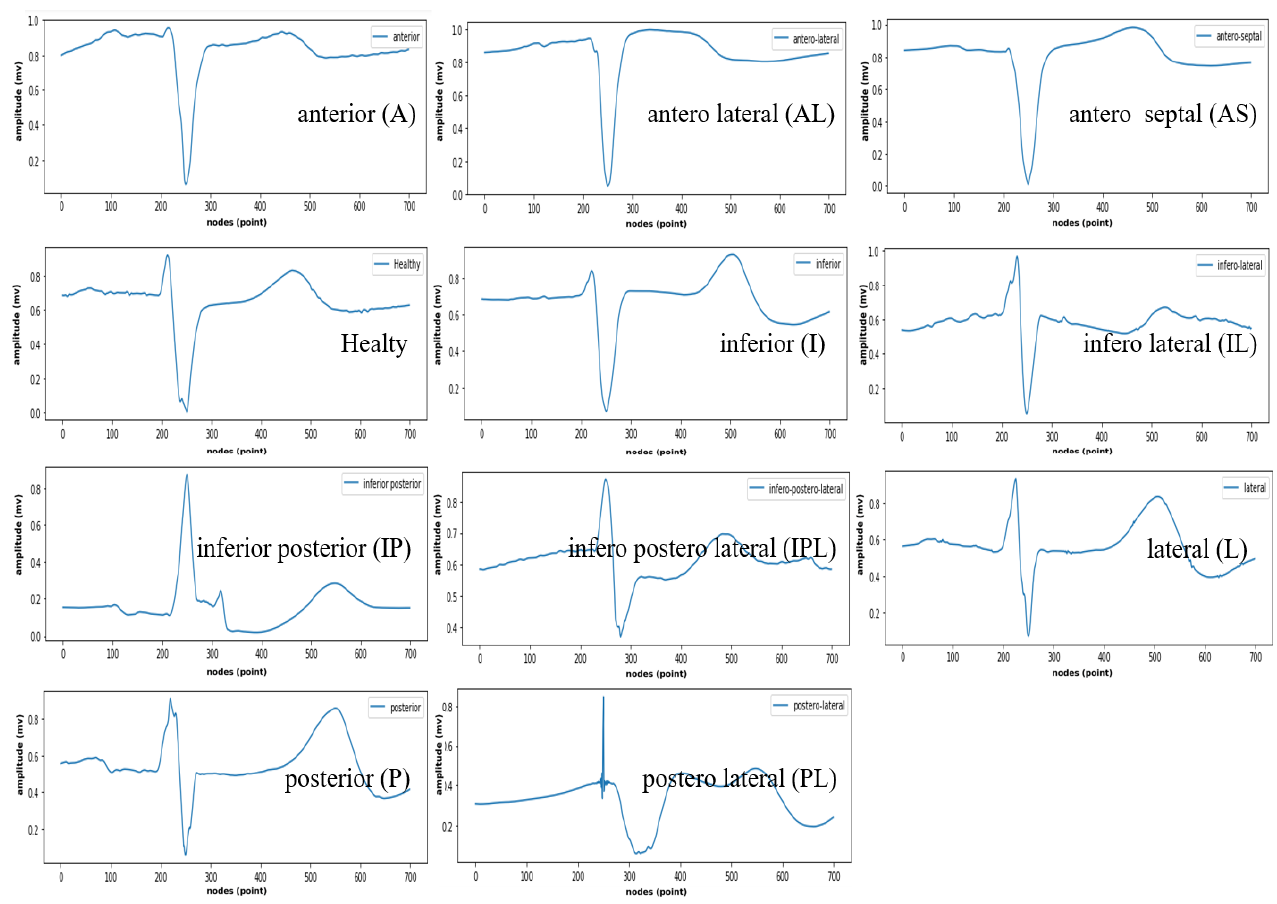
Figure 3. 10 MI and Normal classes in lead v2.